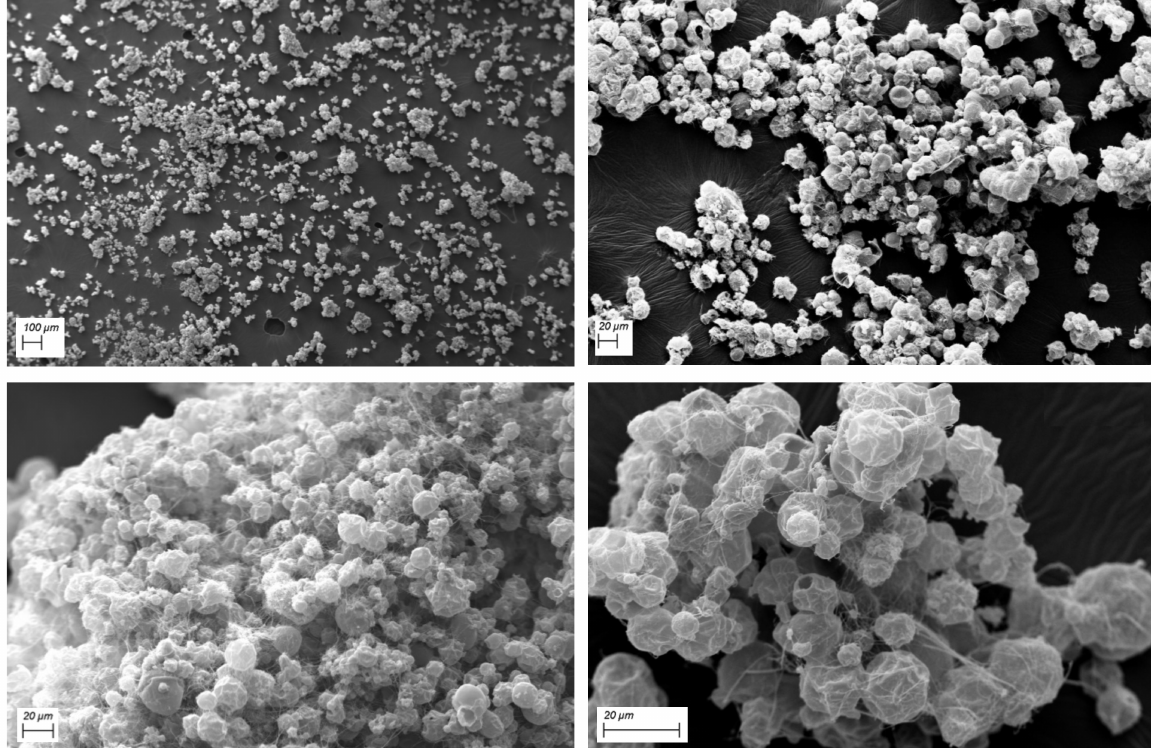
Figure 7. Morphology of RSV-B spray-dried powder evaluated by scanning electron microscopy (SEM) at different magnifications in order to verify microparticles’ diameter and sample